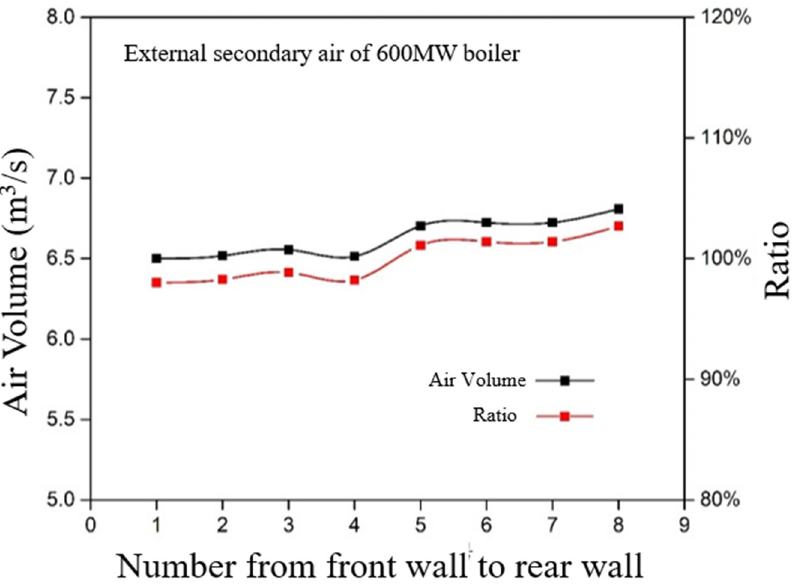
Figure 10. The calculated value of external side upper secondary air exit flow.